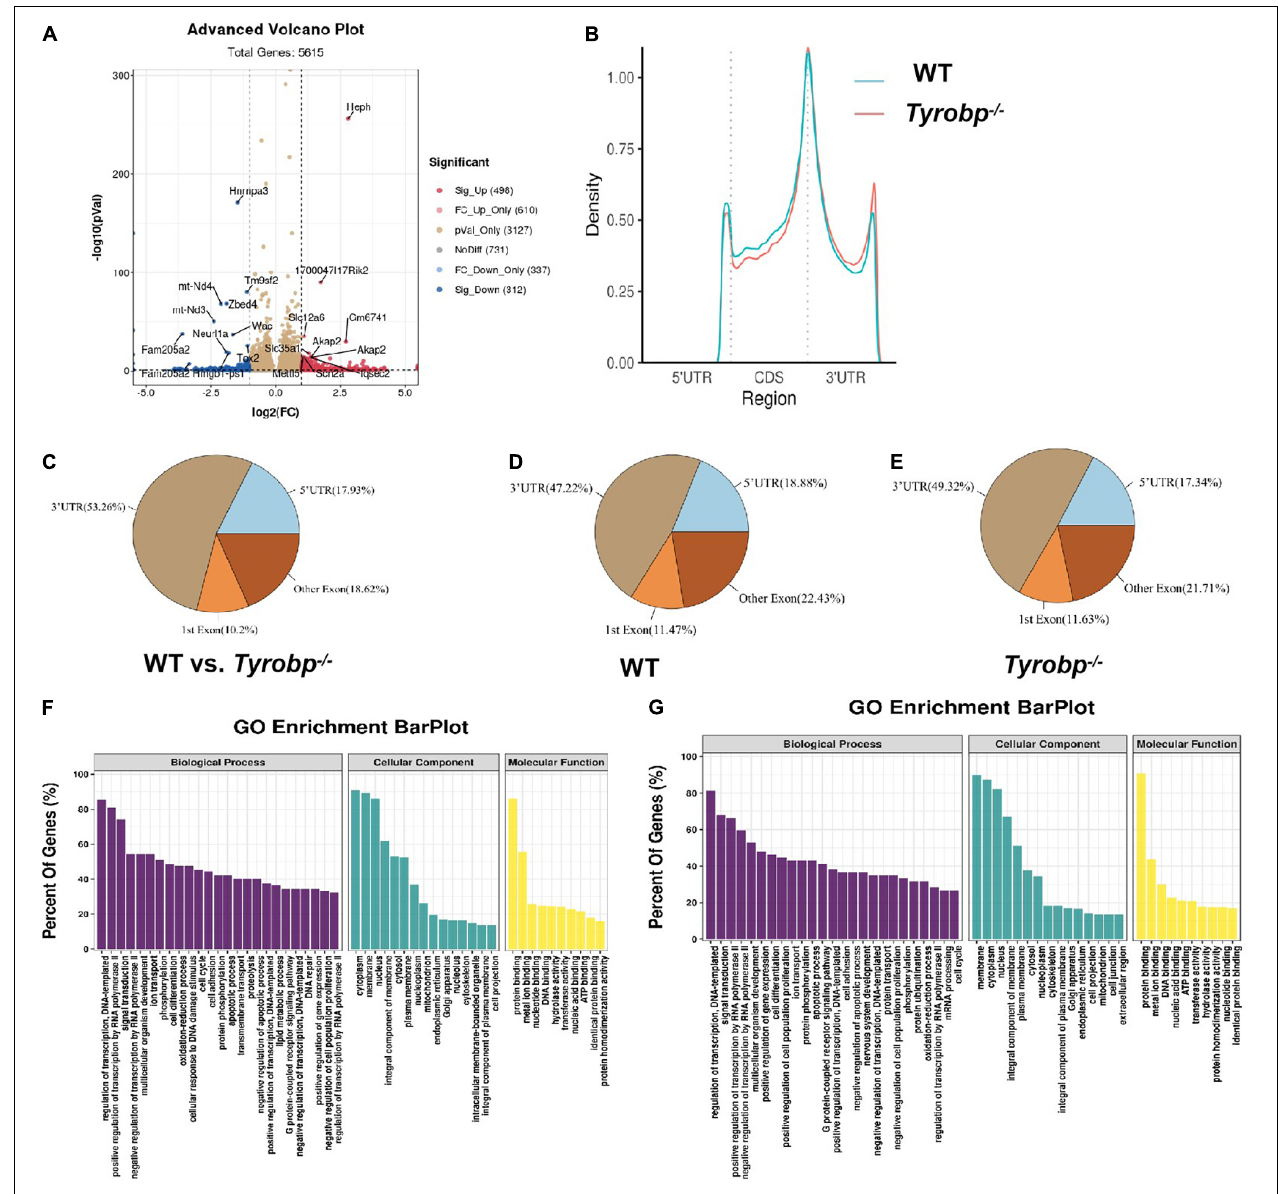
FIGURE 6 | Characteristics of m6A methylation in the hippocampus of 6-month-old Tyrobp − / − mice. (A) Volcano plots showing m6A peaks differing significantly between Tyrobp − / − and wild-type (WT) mice. (B) Average distribution of m6A peaks along transcripts in the hippocampus. (C–E) Pie charts showing the distribution of m6A peaks. (F) Major Gene Ontology terms for transcripts whose m6A methylation was upregulated in Tyrobp − / − mice. (G) Major Gene Ontology terms for transcripts whose m6A methylation was downregulated in Tyrobp − / − mice. Up- or downregulation was defined, respectively, as fold change ≥ 2 or fold change ≤ –2 combined with P < 0.05. Nine mice were used in each